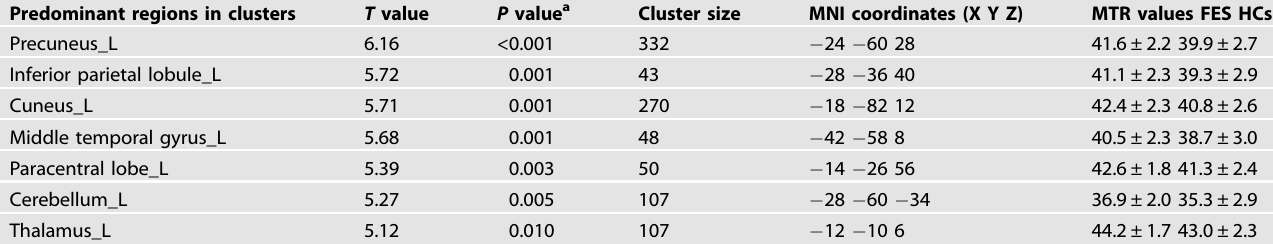
Table 2. Differences in magnetization transfer ratios between antipsychotic-naïve fi rst-episode schizophrenia and healthy controls. Predominant regions in clusters